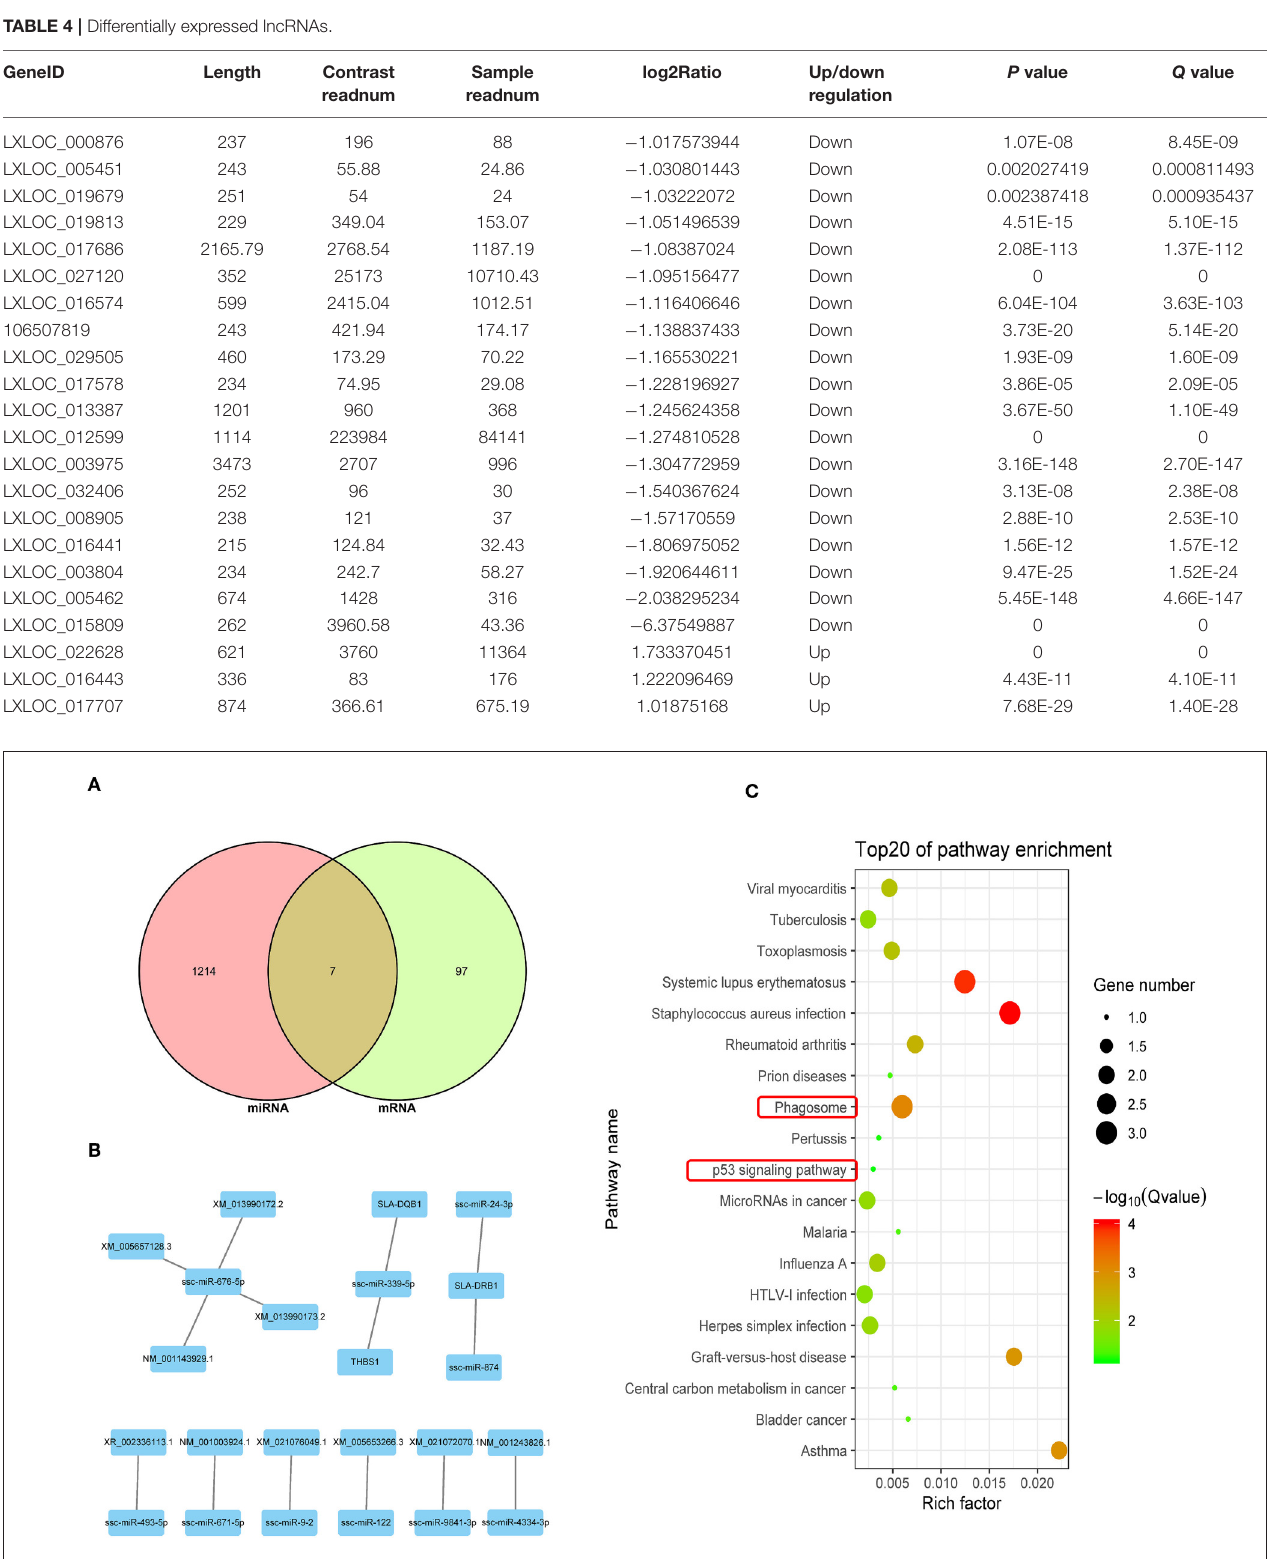
FIGURE 5 | Integrated analysis of DEGs and DEmiRNA target genes. (A) Venn map analysis of DEmiRNA target genes and DEGs. Seven co-expressed genes from the DEGs and DEmiRNA target genes were shown. (B) Regulatory relationship between DEGs and DEmiRNAs. Nine DEmiRNAs that are related to the DEGs regulatory were shown. (C) KEGG analysis based on reciprocal DEmiRNAs and DEGs ( P < 0.05). The phagosome and p53 signal are the main pathway that are related to cells apoptosis.